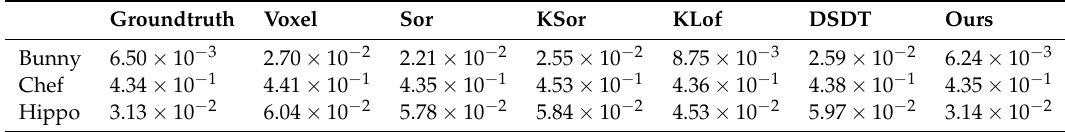
Table 2. RMSE comparison of